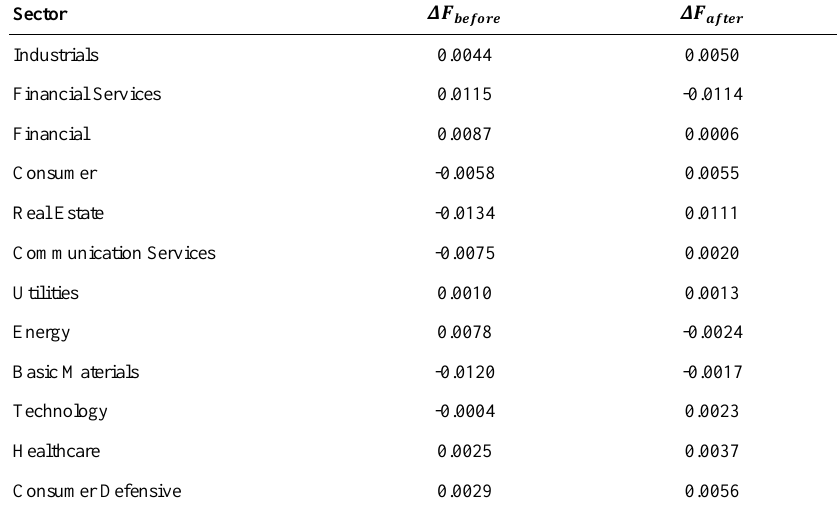
Table 9. The net information outflow for the sectors in QSE market, before and after COVID-19 outbreak